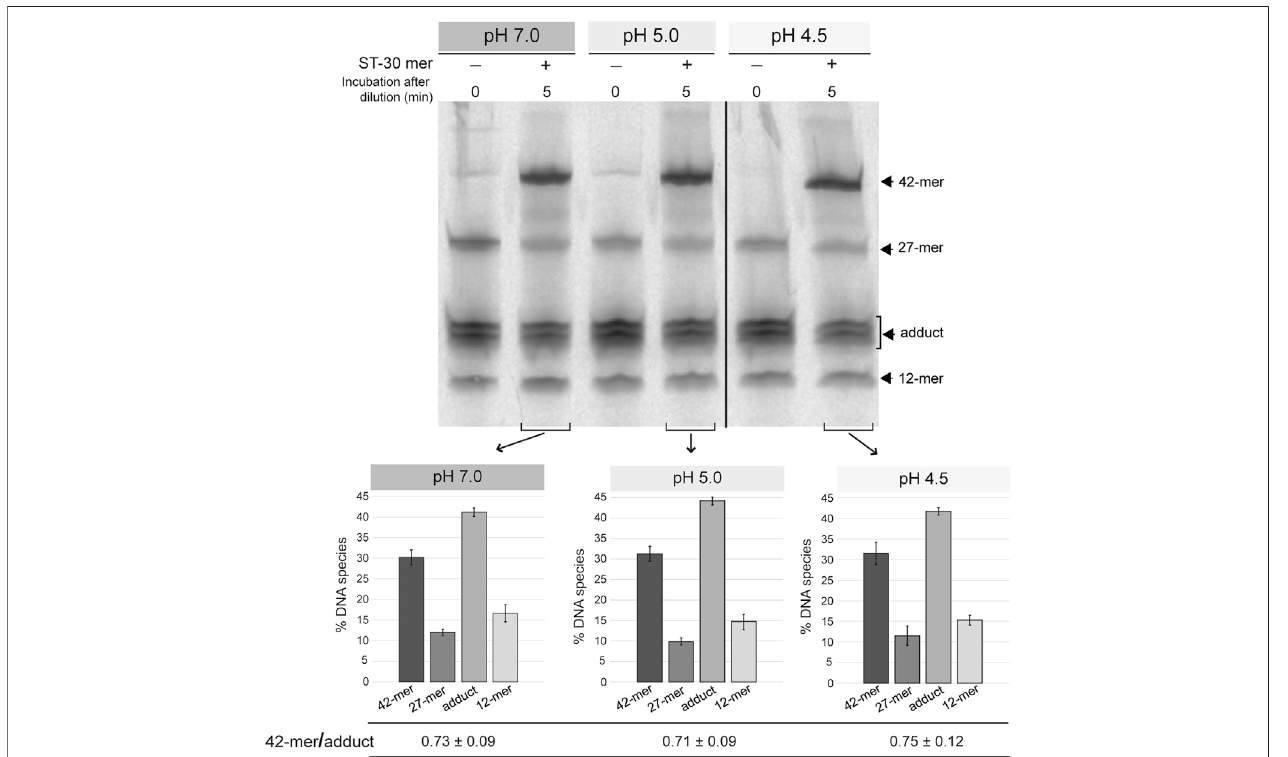
FIGURE 3 | Strand-transfer activity of OBD at different pHs. Gel showing the reaction products that arise from the strand-transfer activity of OBD at different pHs. After setting up anicking reaction (OBD:27-mer molar ratio of 1:1) in reaction buffer 7 at 25 ° C for 1 min, the mixture was diluted 10 times in buffers 7, 5.0, and 4.5. Next, the unlabeled 30-mer oligo was added to a 50-fold molar excess relative to the initial 27-mer oligo and the strand-transfer reaction was allowed to proceed for 5 min underthesameconditionsusedforthenickingreaction.Aliquotsofthethreereactionsweretakenandanalyzed.Aliquotsofthedilutedreactionsbeforeaddingthe 30-mer oligo were also analyzed and used as reference. The bands corresponding to the 12-mer DNA generated by cleavage of the 27-mer substrate and the 42-mer strand-transfer product are indicated (see reaction scheme in Figure 2C ). The covalent adduct is represented by a set of 2 – 3 bands that arise from partial digestion of OBDwithproteinaseK.Arepresentativegelofthreedifferentexperimentsisdisplayed.Belowthegelimage,threebargraphsrepresentthequanti fi cationofthedifferent DNA species generated at the three reaction pHs analyzed. Vertical bars represent the average value of three different experiments and error bars represent standard deviations. The ratio (mean ± SD) between the percentages of the 42-mer product and the adduct for each quanti fi cation is also